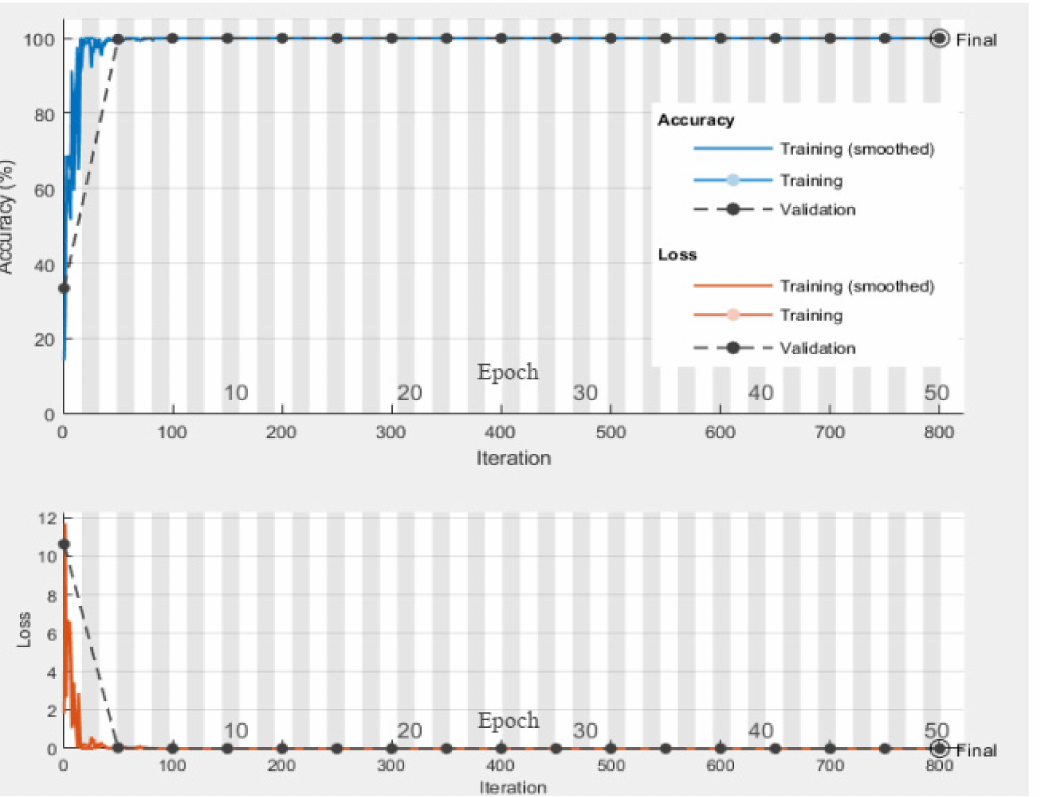
Figure 9. Accuracy and loss curve of the deep CNN